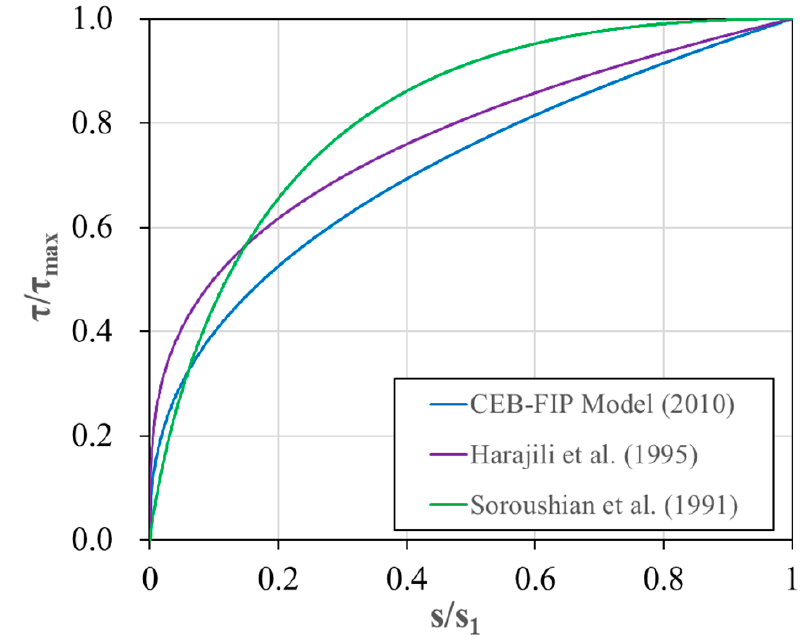
Figure 2. Normalized bond stress-slip curve for the ascending part of the previous models [34,36,37].